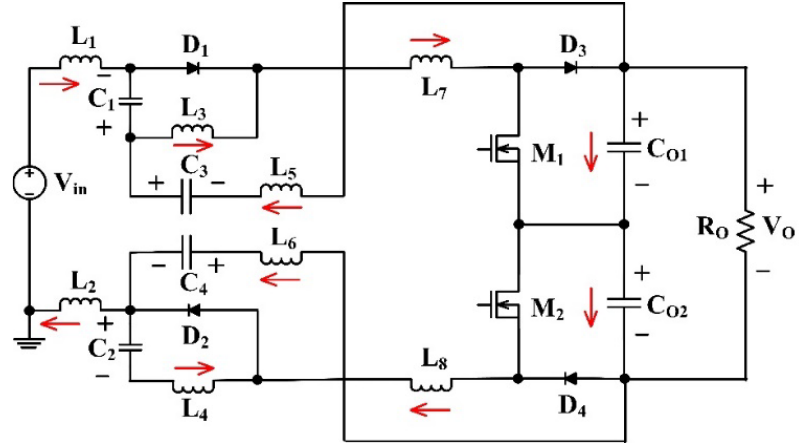
Figure 2. The circuit arrangement of the proposed converter.